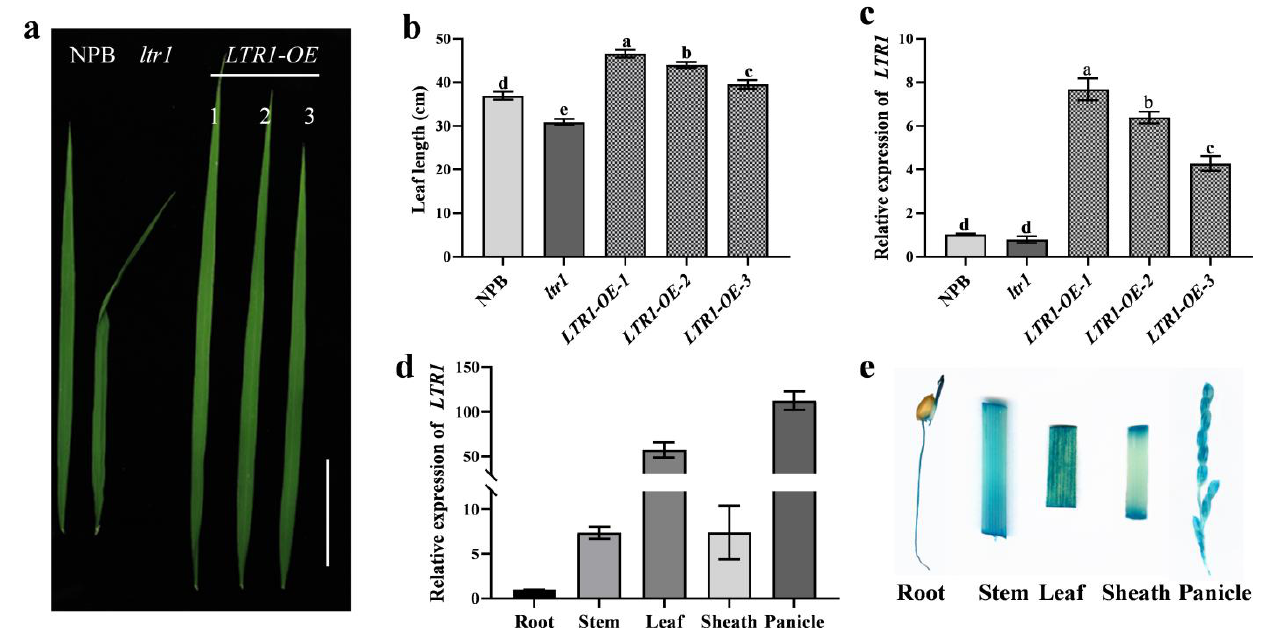
Figure 5. Overexpression and expression pattern analysis of LTR1 . ( a ) Phenotypic investigation of overexpression lines of LTR1 , bar = 6 cm. ( b ) Leaf length of overexpression lines. ( c ) The relative expression level of LTR1 in overexpression lines. ( d ) The relative expression level of LTR1 in different organs of NPB. ( e ) Promoter activities of LTR1 in different organs of NPB as determined by promoter– GUS assays. Data are given as means ± SD. Significant differences were determined by Duncan’s new multiple range test and indicated with different lowercase letters ( p < 0.05).